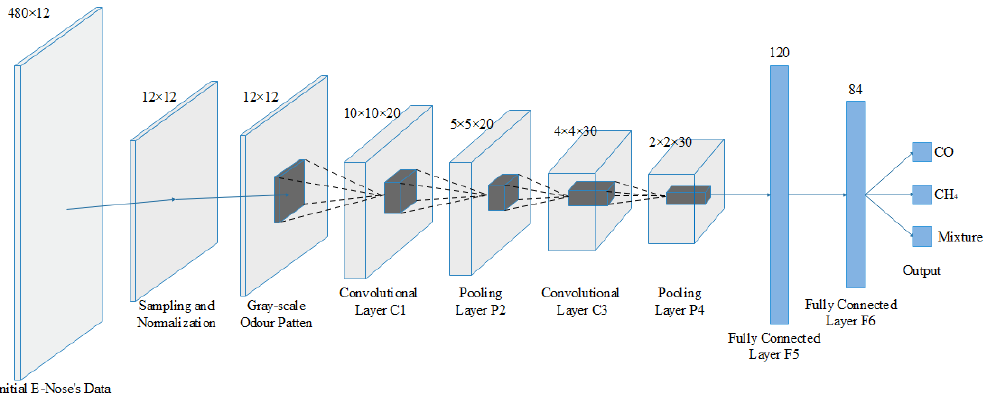
Figure 11. Improved LeNet-5 structure for ENs.